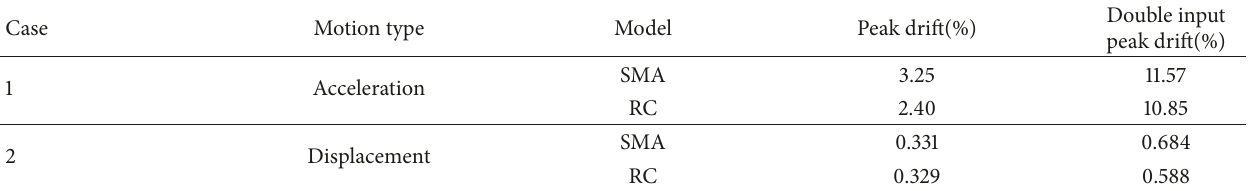
Table 5: Peak drift results of acceleration and displacement excitation in the longitudinal direction